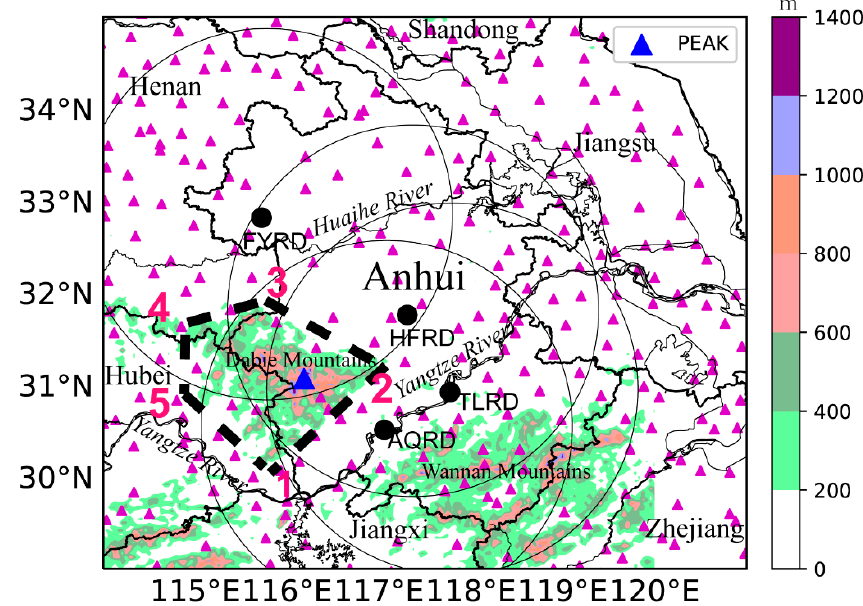
Figure 1. The elevations (shaded, unit: m) and observational stations of severe weather (thunderstorm high winds (THWs) and hails, purple triangle) over Yangtze Huaihe River region. The black dots represent radar stations (‘HFRD’ represents Hefei radar, ‘FYRD’ represents Fuyang radar, ‘AQRD’ represents Anqing radar, and ‘TLRD’ represents Tongling radar). The solid circle represents the detection range of corresponding radar. The bold dashed polygon represents Dabie mountain areas. The blue triangle represents the highest peak of Dabie Mountains.